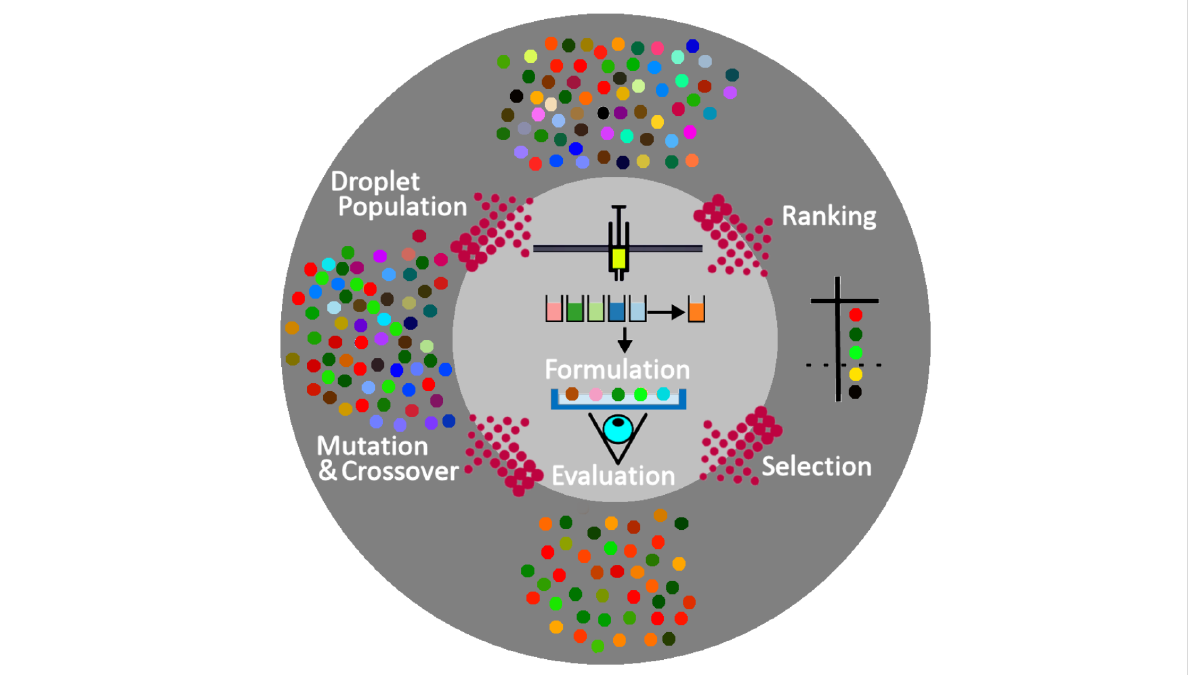
Figure 2: Schematic describing the evolutionary process. The inner circle represents the robotic process and outer circle represents the computa- tional algorithm. A random selection of the droplet formulations are used as the starting ‘Droplet Population’. These droplets are generated in the ‘Formulation’ step. Droplet behaviours are then recorded using a camera, and then undergo image analysis against a user desired property (e.g., colour) in the ‘Evaluation’ step. The droplets are ranked in terms of desired property (e.g., movement, division), and the least good rejected in the ‘Ranking’ step allowing a new population to be ‘Selected’. Meanwhile the accepted formulations are used as a basis to create a new ‘Droplet Population’ after random ‘Mutation’ and ‘Crossover’. This figure was reproduced from our earlier article [13], copyright 2014 Macmillan Publishers Limited.